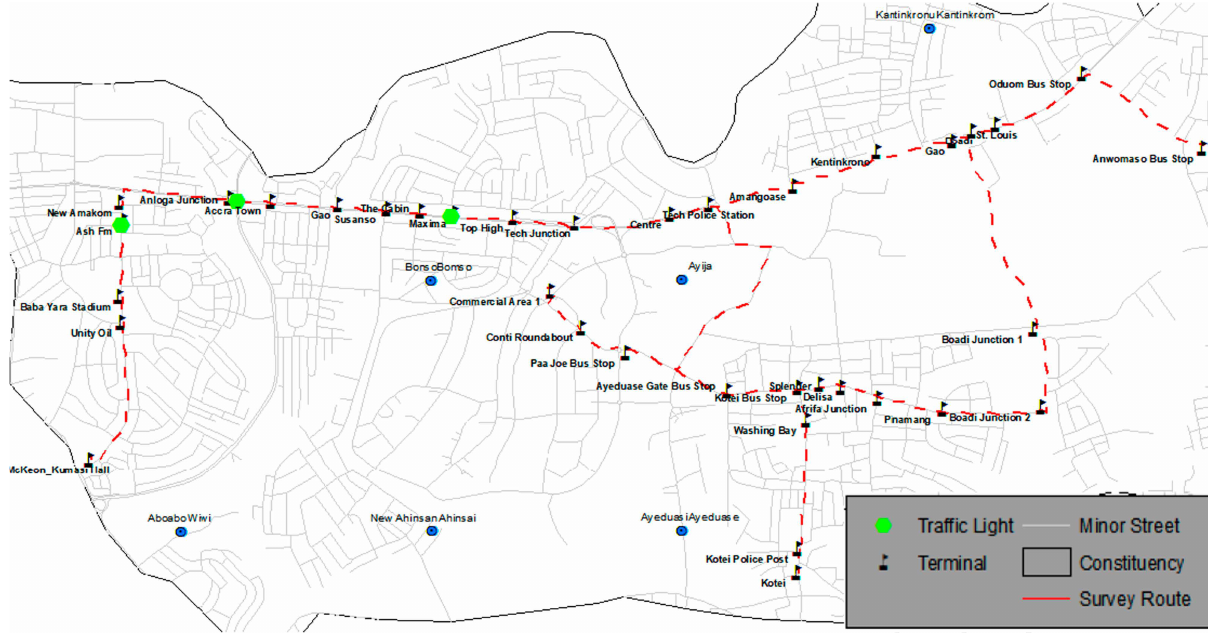
Figure 2: The map of survey route to recording physical attributes at each